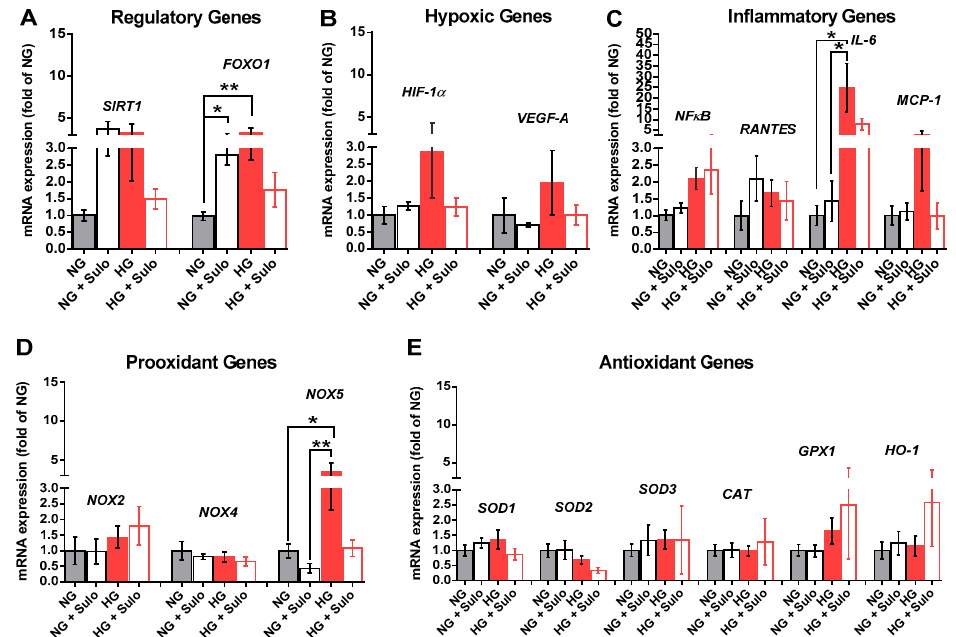
Figure 5. Messenger RNA expression of regulatory genes ( SIRT1 , FOXO1 , A), hypoxic genes ( HIF- 1 α , VEGF-A , B), inflammatory genes ( NF κ B , RANTES , IL-6 , MCP-1 , C), pro-oxidant redox genes ( NOX2 , NOX4 , NOX5 , D), and antioxidant redox genes ( SOD1 , SOD2 , SOD3 , CAT , GPX1 , HO-1 , E) after incubation for two hours with HG (highly concentrated glucose solution; 25 mM D-glucose), HG + Sulo 50 µg/mL (highly concentrated glucose solution + 50 µg/mL sulodexide), NG (normally concentrated glucose solution; 5.5 mM D-glucose), and NG + Sulo 50 µg/mL (NG + 50 µg/mL sulo- dexide). Data are expressed as mean ± SE ( n = 8 per group; * p < 0.05, ** p < 0.01). In each case, mRNA expression levels were normalized to the NG group.